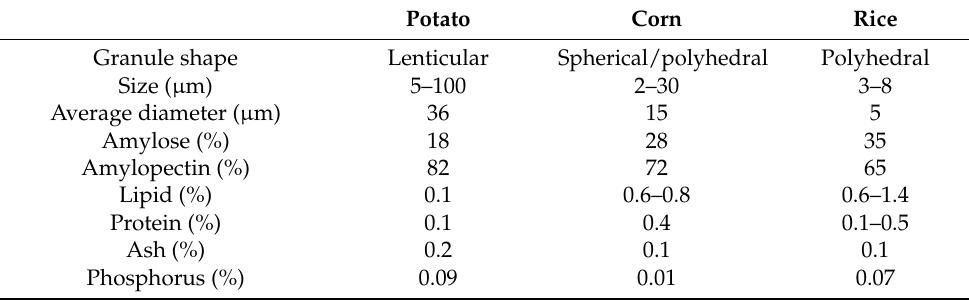
Table 1. Composition and morphological properties of native